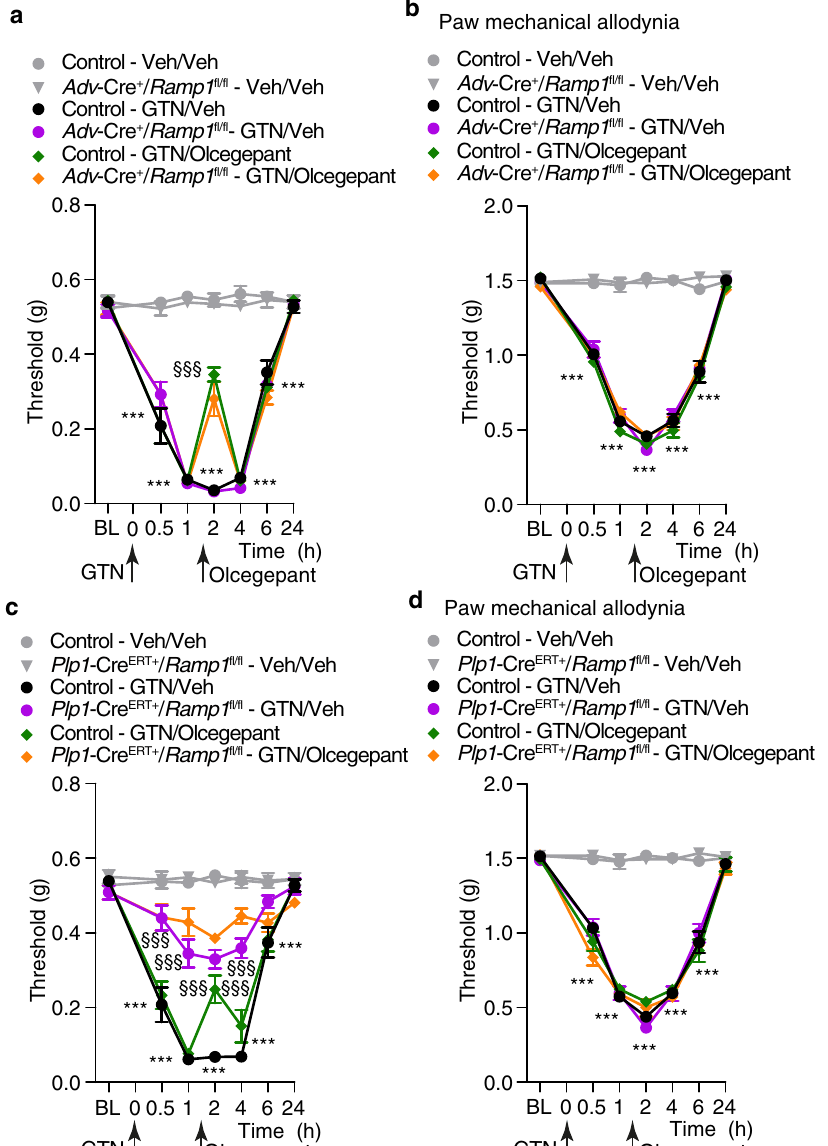
Fig. 3 GTN induces PMA via CGRP released from periorbital trigeminal terminals and, CLR/RAMP1 in Schwann cells. a PMA and ( b ) paw mechanical allodynia induced by intraperitoneal (i.p.) GTN (10 mg/kg) or vehicle in Adv-Cre + / Ramp1 fl / fl or Control mice post-treated (1.5 hs after GTN) with olcegepant (1 nmol) or vehicle. ( c ) PMA and ( d ) paw mechanical allodynia induced by GTN (10 mg/kg, i.p.) or vehicle in Plp1-Cre ERT + / Ramp1 fl / fl or Control (treated with periorbital 4-OHT or vehicle) post-treated (1.5 hs after GTN) with olcegepant (1 nmol) or vehicle. Mean±SEM., n = 8 mice per group. *** P < 0.001 vs. Control-Veh/Veh; §§§ P < 0.001 vs. Control-GTN/Veh. 2-way ANOVA, Bonferroni correction. Source data are provided as a Source Data fi Rluc2- β ARR2 to the plasma membrane (Supplementary Fig. 4g – l) and almost completely inhibited activation of G α s,sq,si and β ARR2 in endosomes of HSCs expressing hCLR/RAMP1 (Fig. 5l, m). to CGRP-induced cAMP formation, we preincubated HSCs expres- sing the cADDis cAMP reporter with sucrose or vehicle. In vehicle- treated cells, CGRP stimulated a rapid (1 min) increase in cAMP formation that was sustained for 30 min (Fig. 5n, o). Sucrose reduced but did not abolish the initial response, yet strongly inhibited the sustained phase of CGRP-stimulated cAMP formation (Fig. 5n, o).